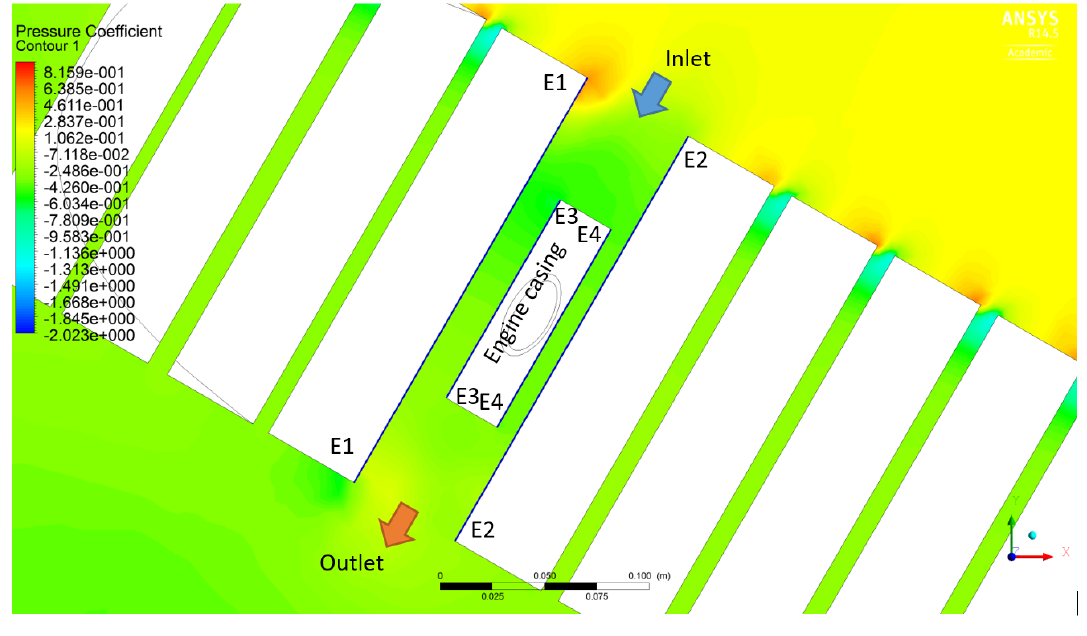
Figure 17. Pressure distributions around the engine casing.